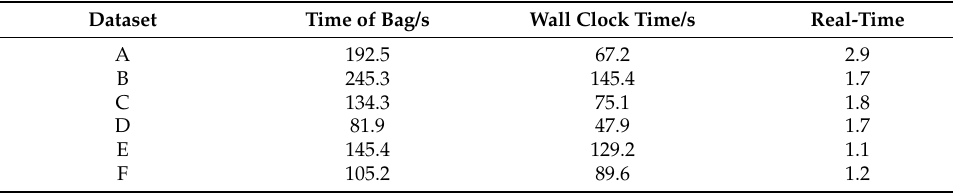
Table 1. Real-time performance of our method.